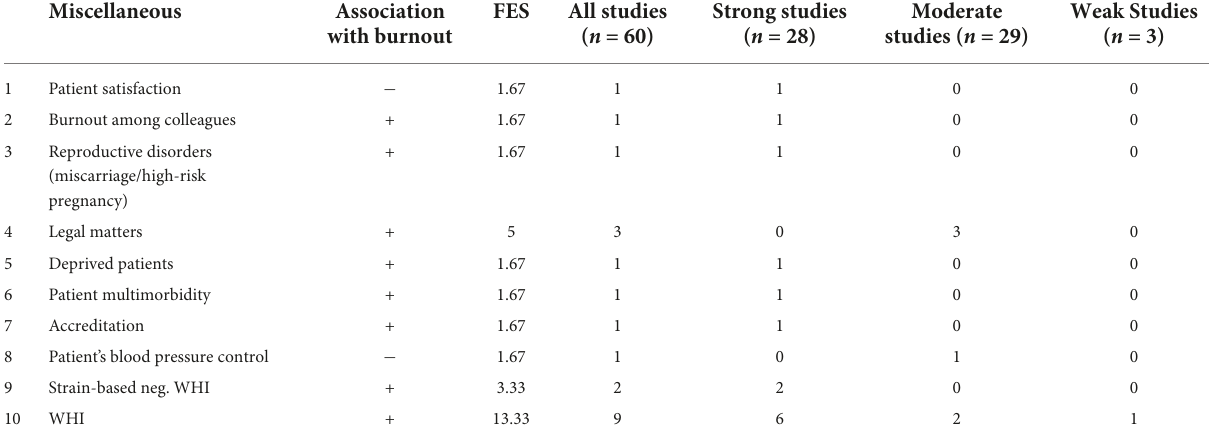
TABLE 7 Study outcomes miscellaneous category [ p -values are calculated according to Fisher exact (Freeman and Julious,